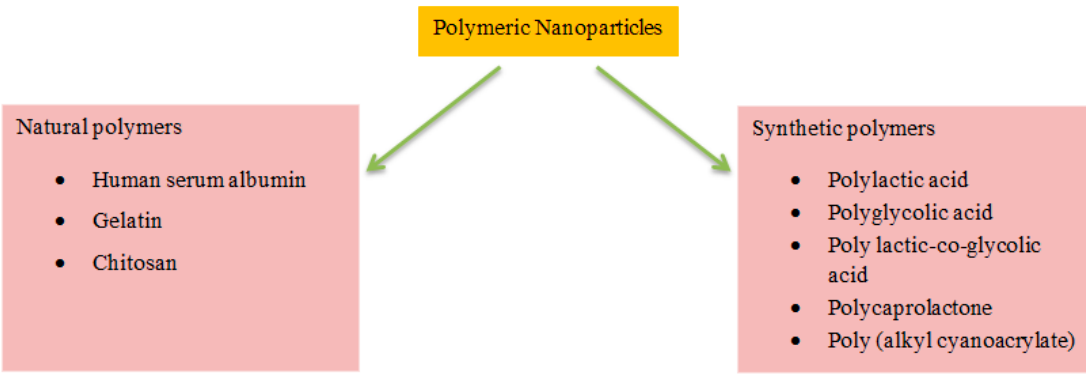
Figure 1. Selected polymeric NPs for the delivery of drugs to the brain.